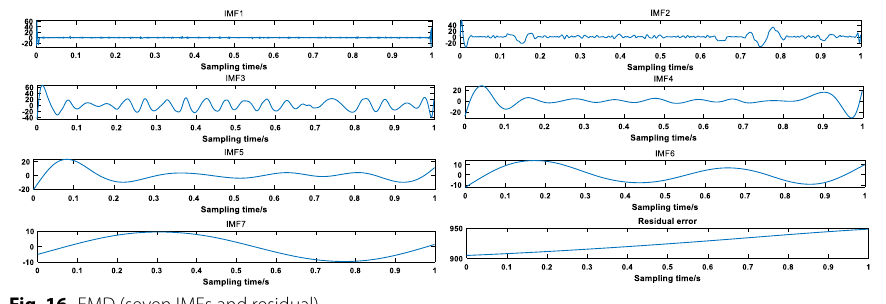
Fig. 16 EMD (seven IMFs and